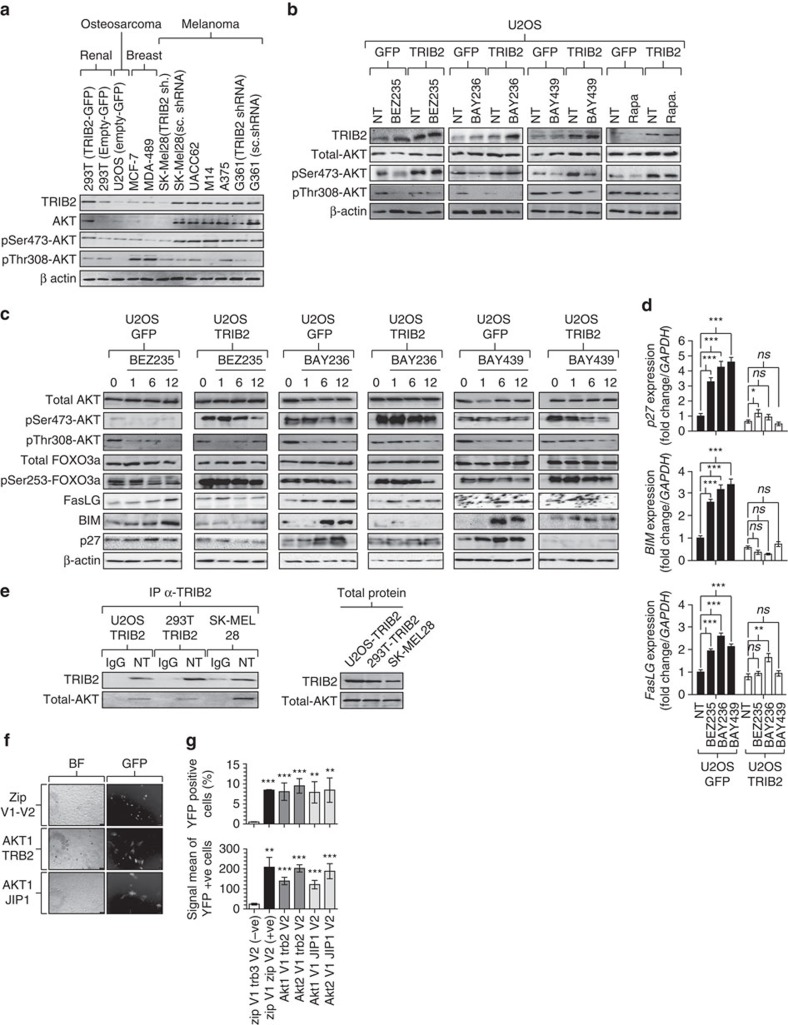
TRIB2 protein expression correlates with AKT activation status and response to PI3K inhibition.(a) TRIB2 protein levels correlate with AKT-Ser473 phosphorylation in a broad range of model in vitro models. Representative images showing 100 μg (TRIB2), 50 μg (AKT-Ser473) total protein loaded per lane separated by 10% SDS–PAGE. sc indicates scramble shRNA within the indicated cell lines. (b) Immunoblot profiles for matched isogenic TRIB2 cell lines for the AKT signalling network. High-TRIB2 expression correlated with significantly increased post-translational modification(s) of downstream AKT targets. (c) Temporal inhibition of PI3K-dependent signalling following exposure to PI3K inhibitors. Total protein lysate of 50–200 μg was loaded per lane and separated by 6–12% SDS–PAGE. (d) FOXO3a-dependent gene expression was evaluated following 12 h treatment with PI3K inhibitors. NT indicates no treatment. *P<0.05 **P<0.01, ***P<0.005 by two-way ANOVA. Data represent the±s.d. ns indicates that the comparison was not statistically significant. (e) (left) Co-immunoprecipitation of TRIB2 or total AKT1 from indicated cell lines, (500 μg total protein lysate immunoprecipitated per lane) and separated by 8–12% SDS–PAGE. (right) Total protein levels in each indicated cell line for co-IP targets (100 μg total protein loaded per lane and separated by 8–12% SDS–PAGE). (f) Representative yellow fluorescent protein (YFP) complementation microscopy analysis assay for the assessment of the interaction between AKT1/2 and TRIB2. The leucine zipper Venus1 and Venus2 (ZIPV1-V2) constructs were used as a positive control, while the combination of TRIB3 V2 and V1 are our negative control. AKT1/2 JIP1 constructs were an additional control of a known AKT protein/protein complex. BF indicates bright field. (g) (top) Percentage of YFP positive cells determined by FACS. (bottom) Mean fluorescent intensity of YFP positive cells. One-way ANOVA with Dunnett's multiple comparison test, n=4 (*P≤0.05, **P≤0.01, ***P≤0.001). All analysis was conducted compared to zipV1trib3V2 (lane 1).